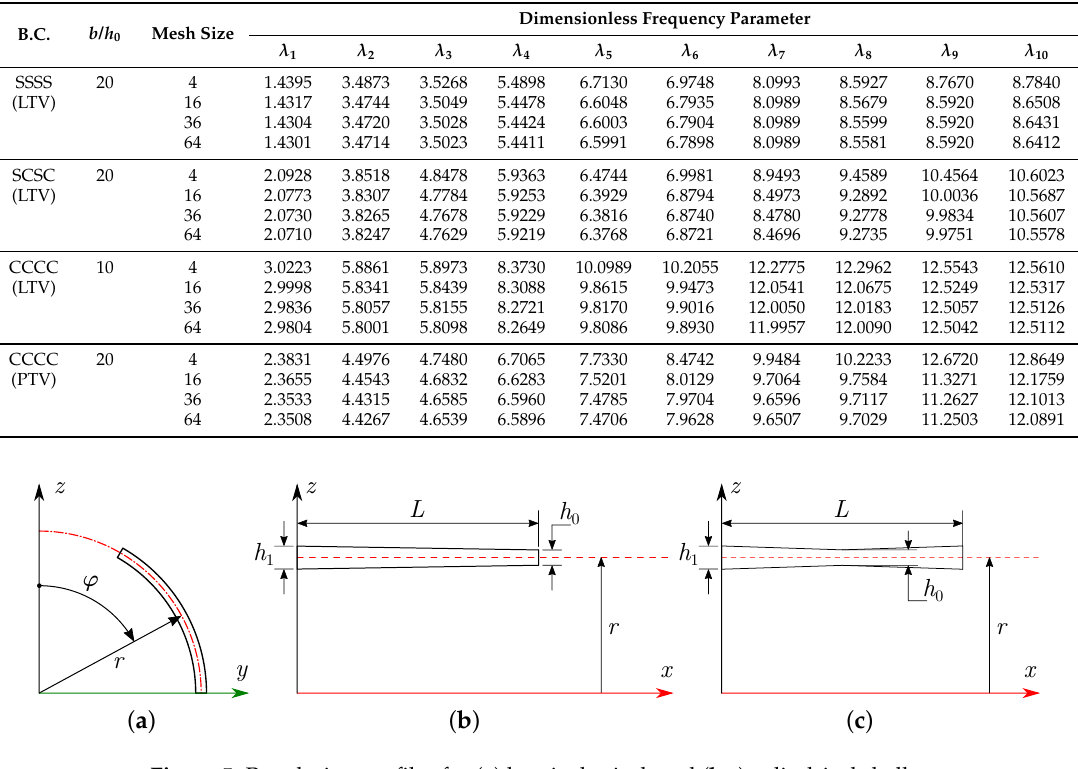
Figure 5. Revolution profiles for ( a ) hemispherical, and ( b , c ) cylindrical